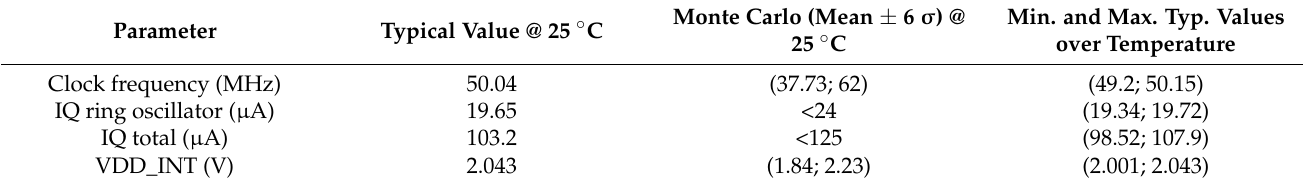
Table 4. Results summary for 5 V supply